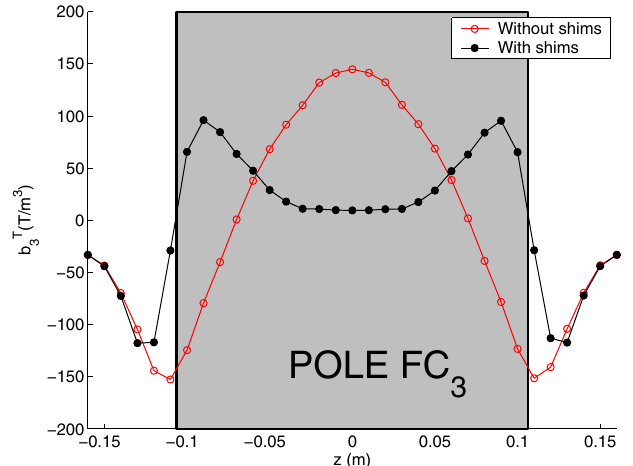
FIG. 18. (Color) Third order term of the field expansion as a function of z without and with the